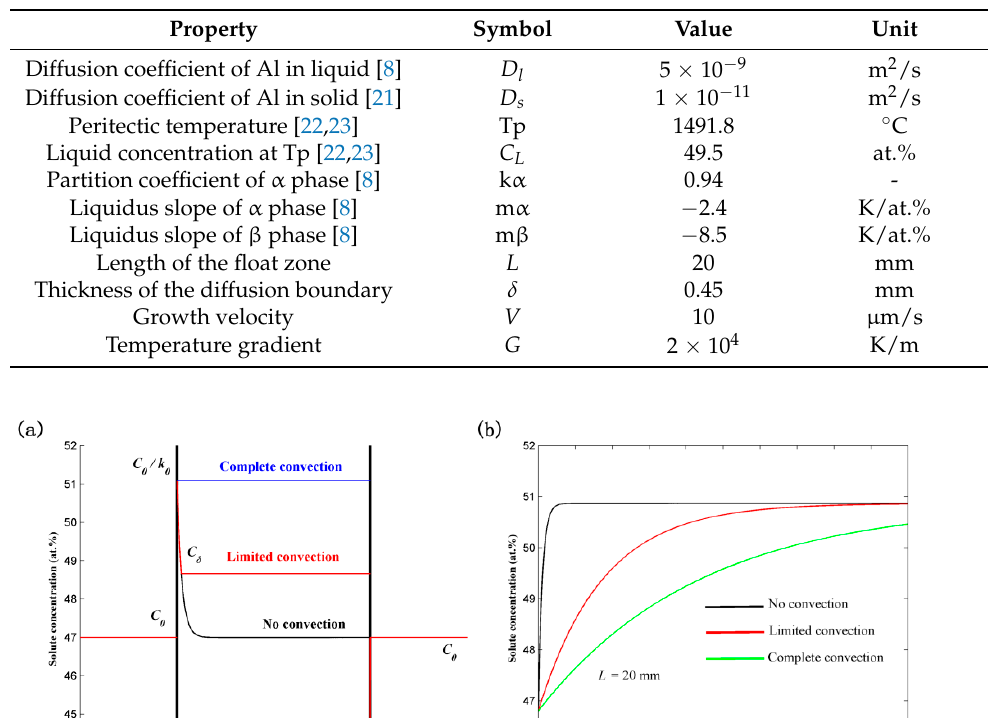
Table 1. Material properties of TiAl alloy.